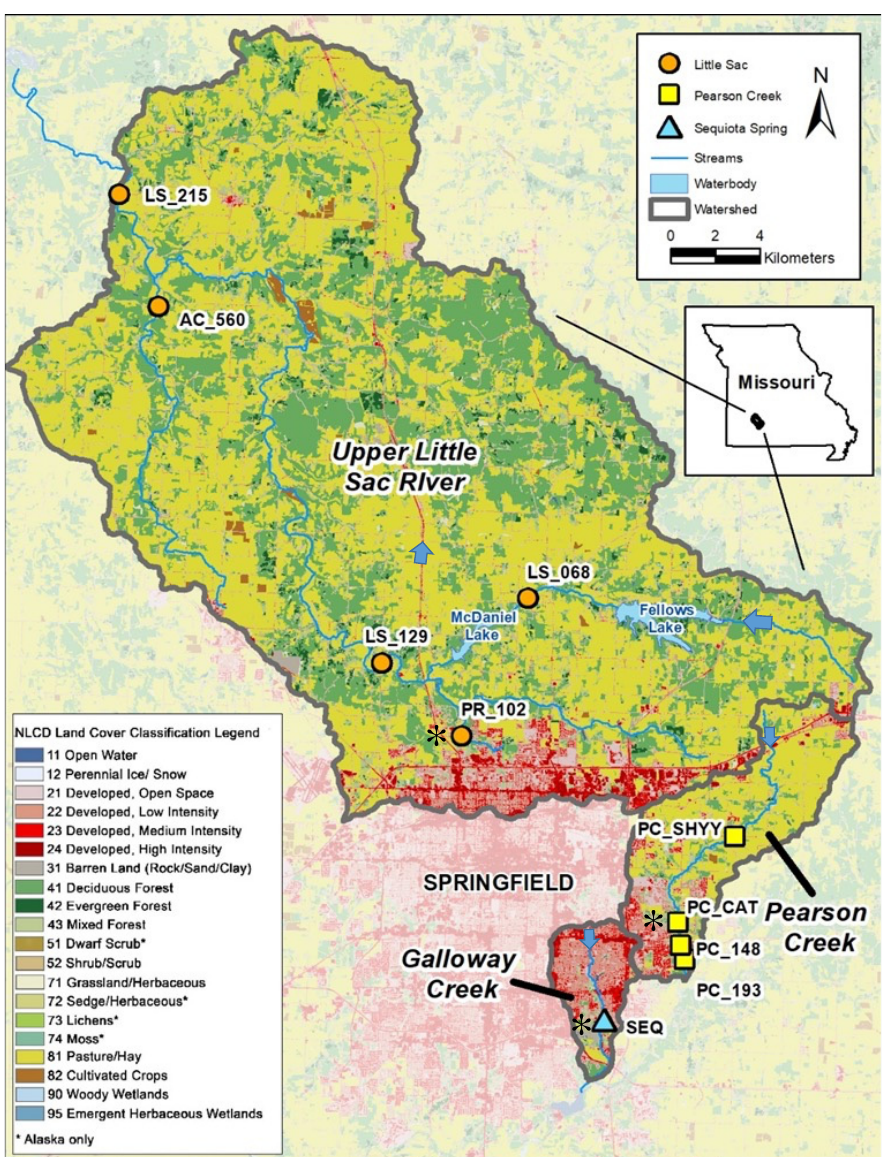
Figure 1. Sampling sites demonstrating urbanization (indicated by the red color in the map). Five sampling sites in Little Sac watershed (golden circles), four site in Pearson Creek (yellow squares) and Sequiota Spring (aqua triangle) in the James River Basin were selected for Next-Gen DNA sequencing. The three sites (PR_102, PC_Cat and Seq spring) that displayed a high abundance of pathogen-related sequences are marked with black asterisk ( ∗ ). Blue arrows indicate the direction of water flow.